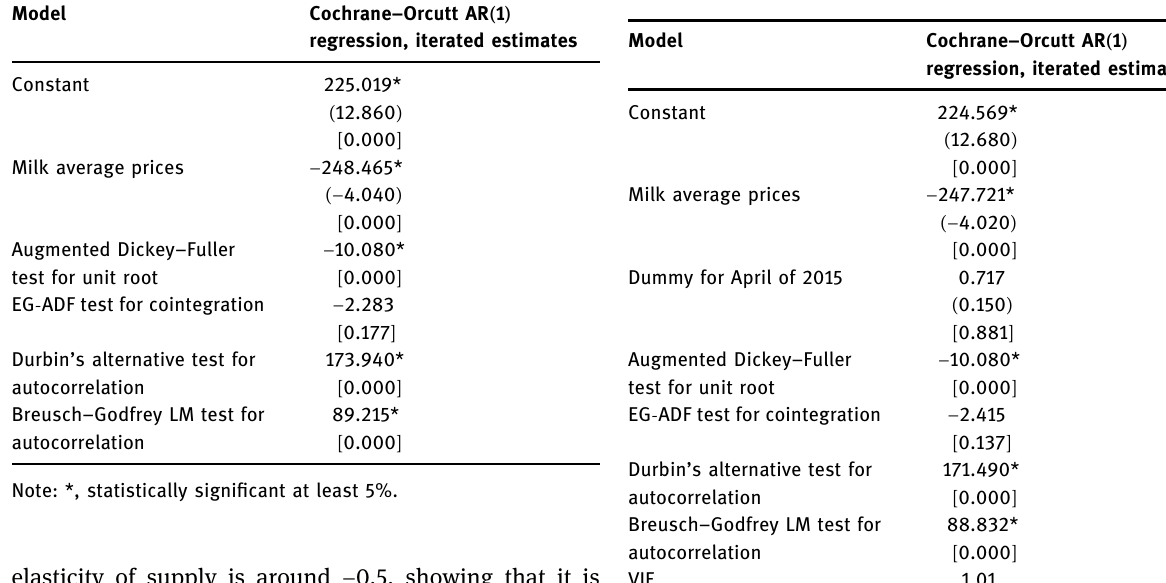
Table 2: Results for times series regression between the raw cows ’ milk delivered to dairies ( millions kilograms ) and the average prices ( euro/kg ) , for the months of the period 2005 – 2019, with